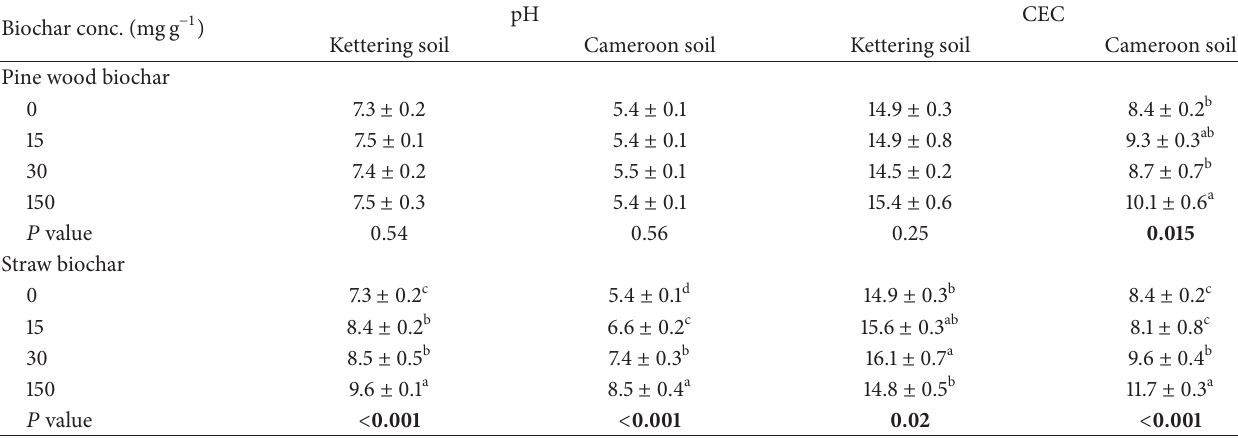
and cation exchange capacity (CEC; cmolKg − 1 soil) of Kettering Table 1: Effect of biochar concentration and biochar feedstock on soil pH water and Cameroon soils. Data are mean ± SEM ( 𝑛 = 3 ) and 𝑃 values are derived from one-way ANOVA with biochar concentration as the factor. Mean values within each soil and biochar type combination sharing the same letter are not significantly different ( 𝑃 > 0.05 ). pH CEC Biochar conc. (mgg −1 ) Kettering soil Cameroon soil Kettering soil Cameroon soil Pine wood